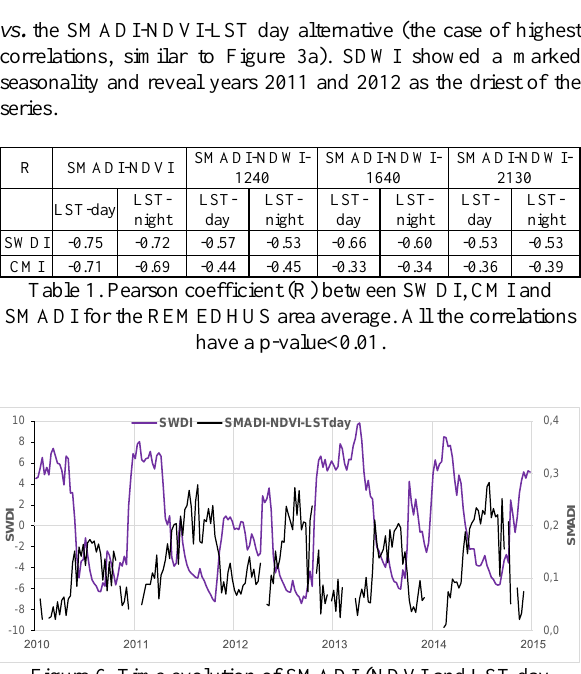
Figure 6. Time evolution of SMADI (NDVI and LST day version) and SWDI at REMEDHUS.